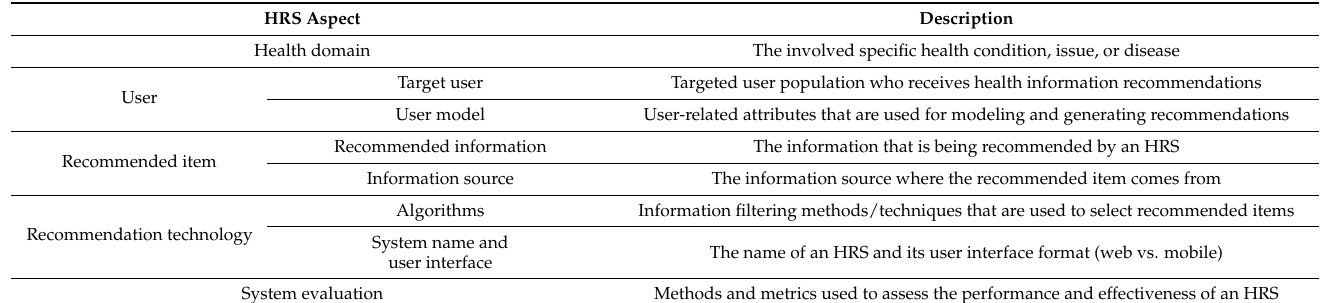
Table 1. Main components of